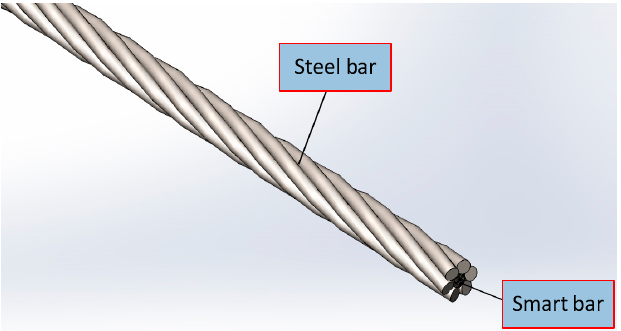
Figure 2. Schematic diagram of a smart composite prestressed tendon.